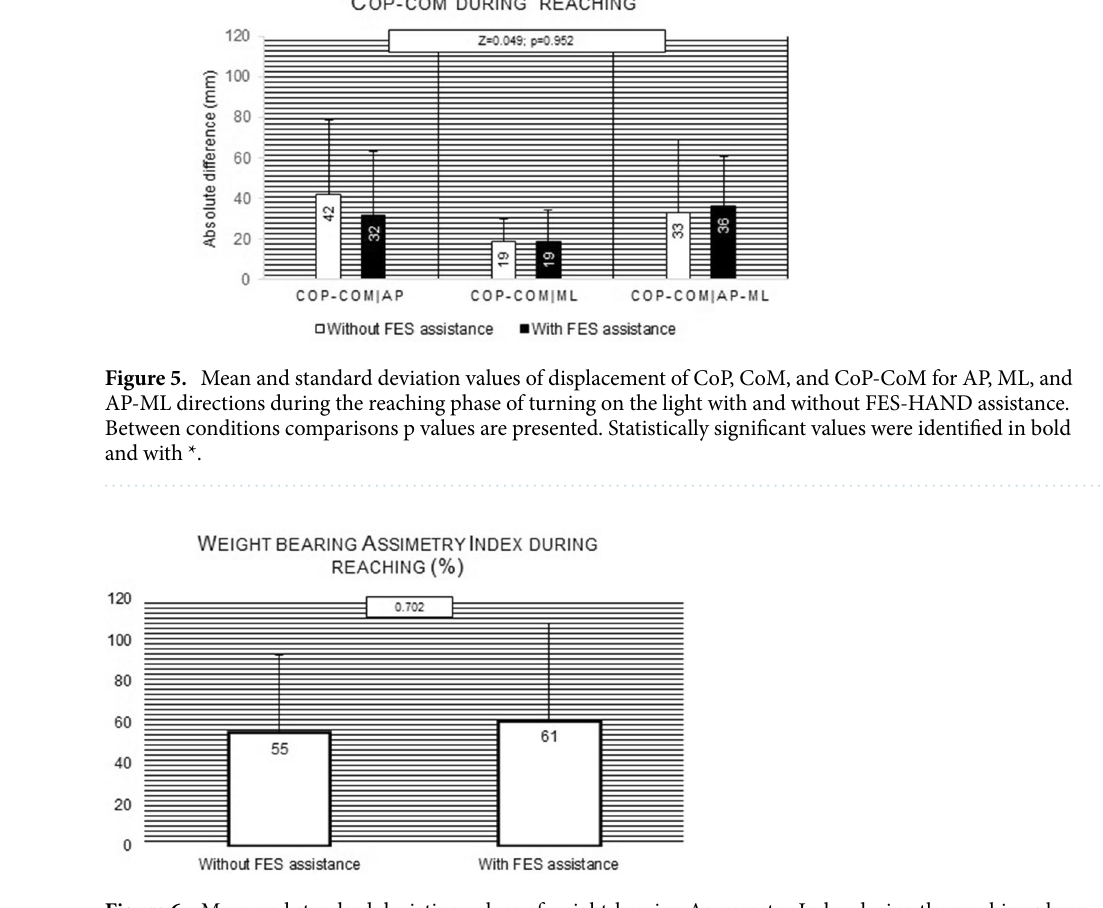
Figure 6. Mean and standard deviation values of weight-bearing Asymmetry Index during the reaching phase of turning on the light with and without FES-HAND assistance. Between conditions comparisons p values are